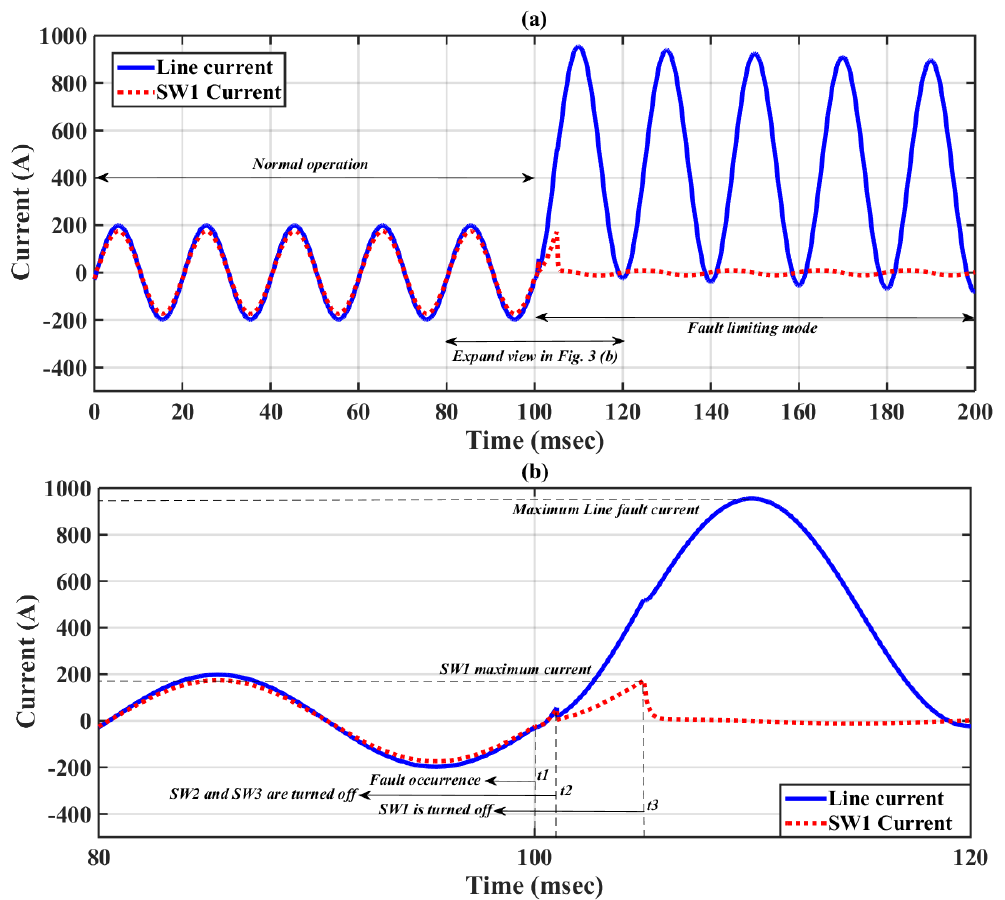
Figure 6. ( a ) Line and SW1 switch currents during normal and fault conditions affected by HBFCL ff ected by and ( b ) PCC voltage during normal and fault conditions affected by HBFCL. ( b ) PCC voltage during normal and fault conditions a